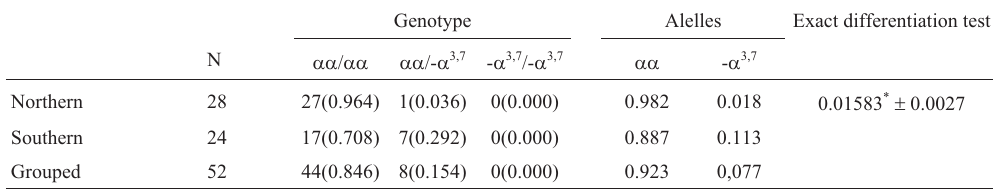
Table1 -Genotypeandallelefrequenciesofthe- (cid:2) 3,7 deletionandresultsofthedifferentiationtestbetweentheNorthernandSouthernsub-populations. Genotype Alelles